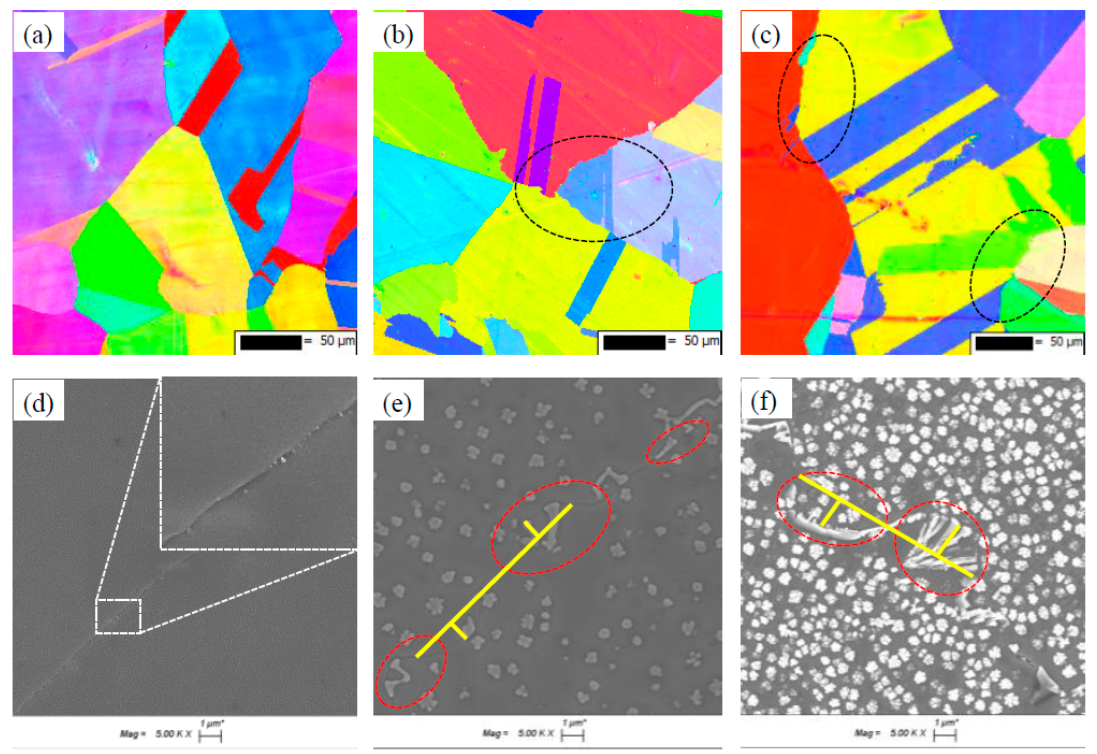
Figure 7. The morphology of the grain boundaries under different cooling rates. ( a ) IPF map at water quench, ( b ) IPF map at 5 °C/min, ( c ) IPF map at 1 °C/min, ( d ) SEM at water quench, ( e ) SEM at 5 °C/min, ( f ) SEM at 1 °C/min.